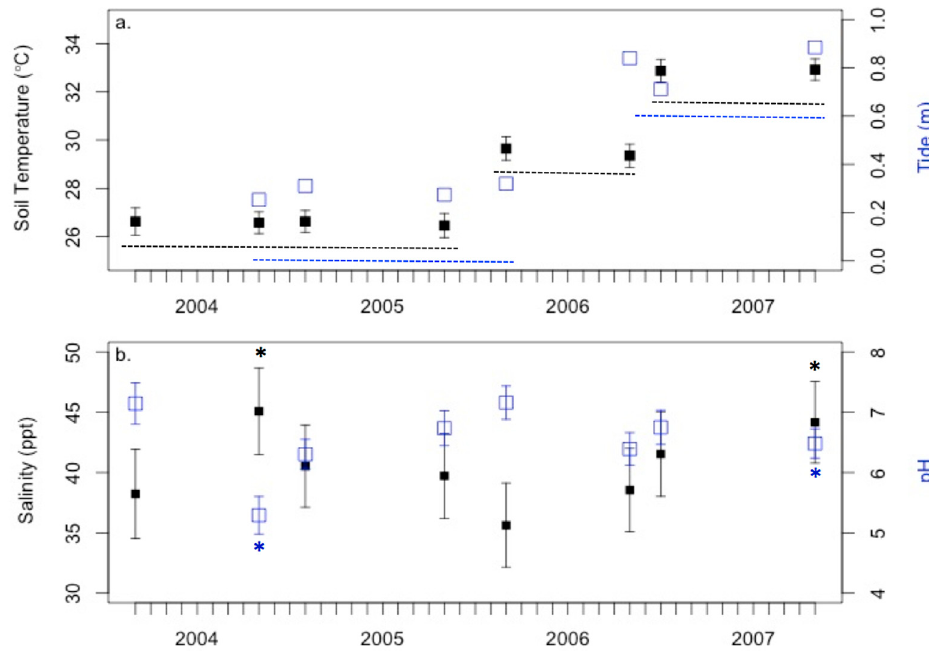
Figure 6. Environmental conditions least square means over the study period. ( a ) sediment temperature (black) and tide (blue) increased over the study periods. Dotted lines indicate which timeframes were similar statistically; ( b ) Salinity (black) and pH (blue) fluctuated and asterisks (*) denote timeframes with statistically high or low conditions. Error bars denote standard errors.